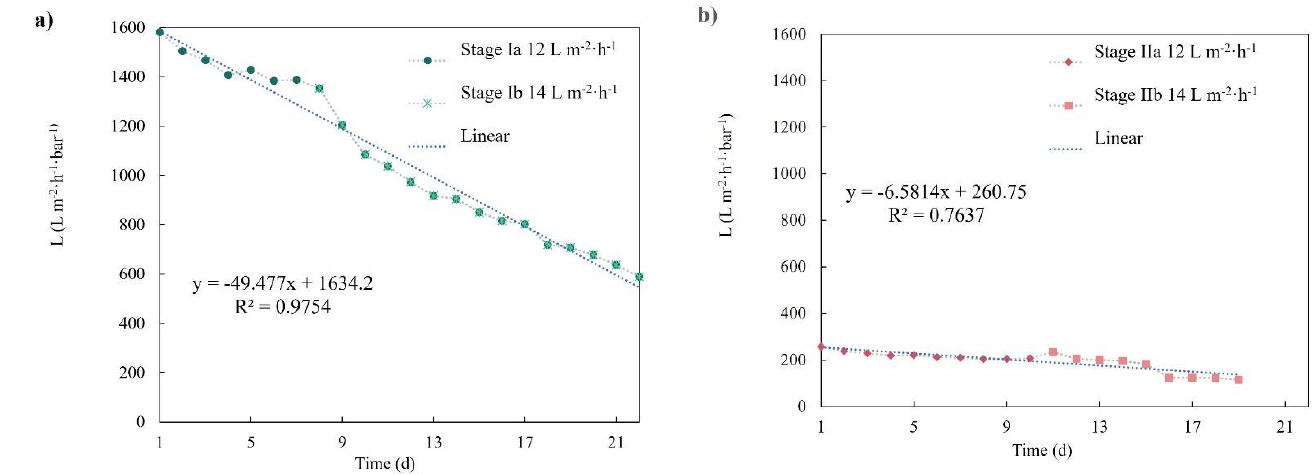
Figure 6. ( a ) Permeability evolution for the c-MF membrane in stages Ia and Ib and ( b ) the r-UF membrane in stages IIa and IIb. membrane in stages IIa and IIb. Table 3. Summary of membrane permeability decline values for the different operating stages.